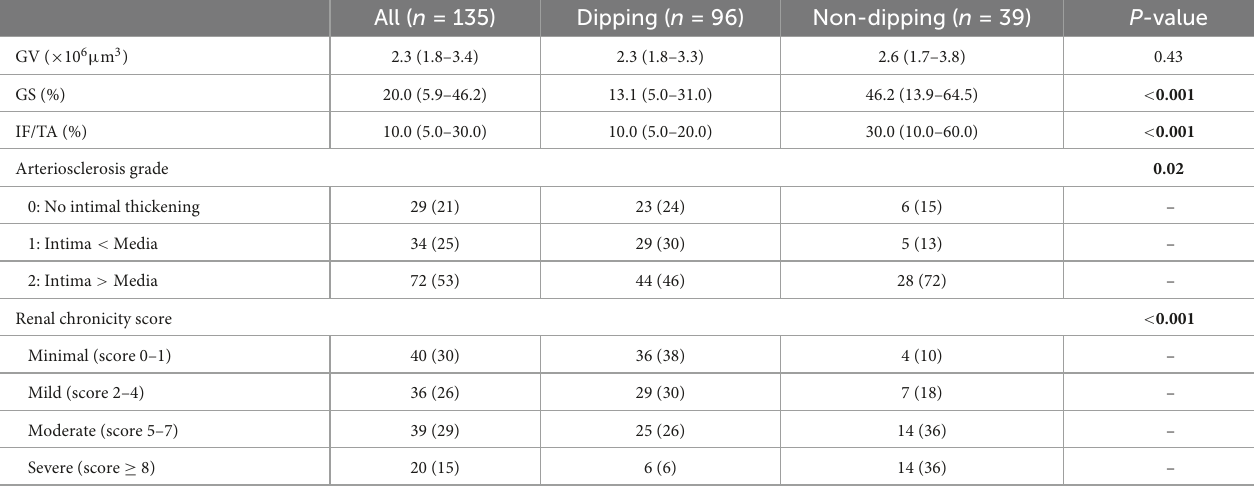
TABLE 3 Microanatomical structural characteristics of the subjects according to the dipping and non-dipping pulse rate